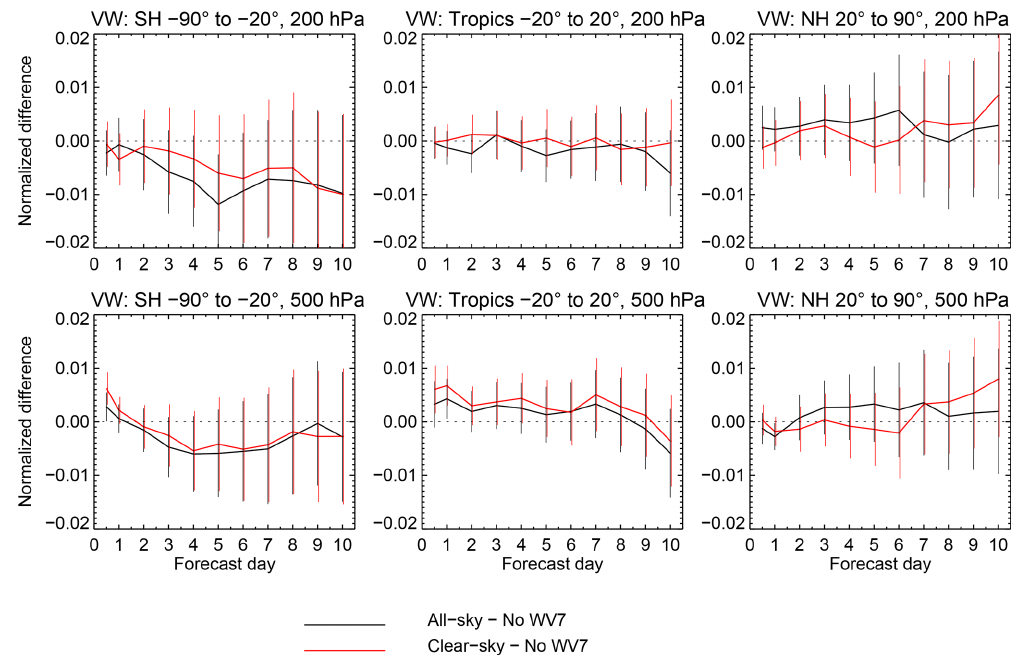
Figure 11. Change in vector wind RMSE due to assimilation of the seven IASI WV channels using either the clear-sky approach (red) or all-sky approach (black). Change in RMSE is relative to an experiment in which the seven IASI WV channels are not assimilated, normalized by the RMSE of the no-observation experiment. Error bars indicate 95% confidence range with a ˘Sidák correction for eight independent tests, following Geer